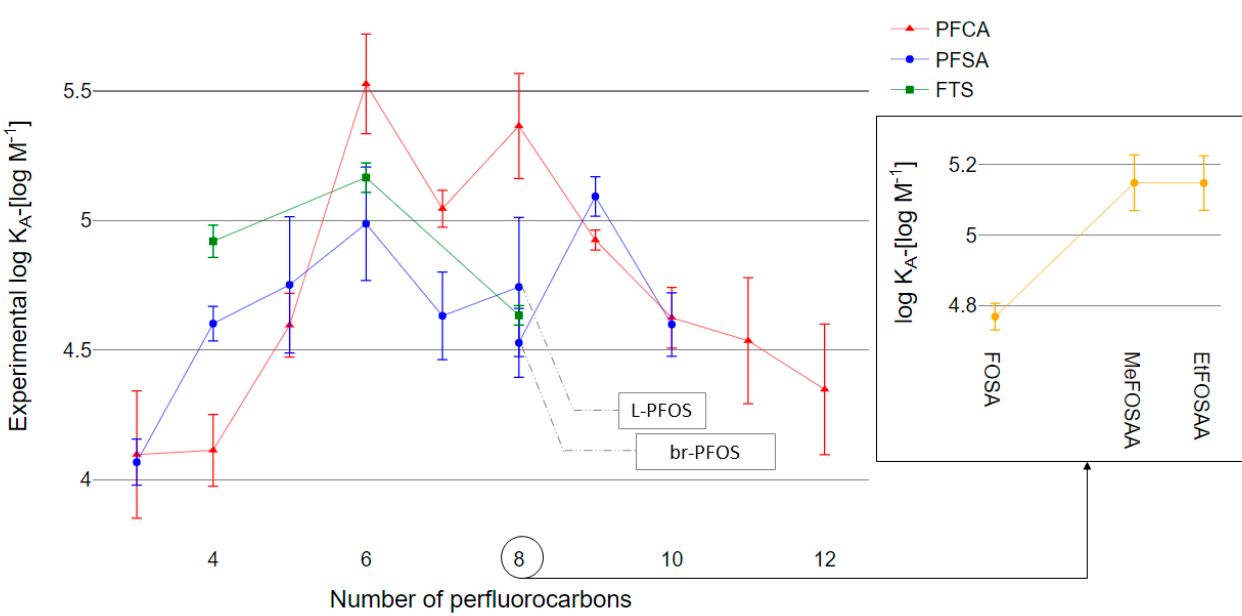
Figure 2. Experimentally determined noncovalent association constants (K A ) of 26 PFAS targets with human serum albumin (has) in equilibrium dialysis. Three C 8 precursor compounds, Perfluoro-1-octanesulfonamide (FOSA), N-methylperfluoro-1- octanesulfonamidoacetic acid (MeFOSAA), and N-ethylperfluoro-1-octanesulfonamidoacetic acid (EtFOSAA) are presented in a separate plot. The error bars represent one standard